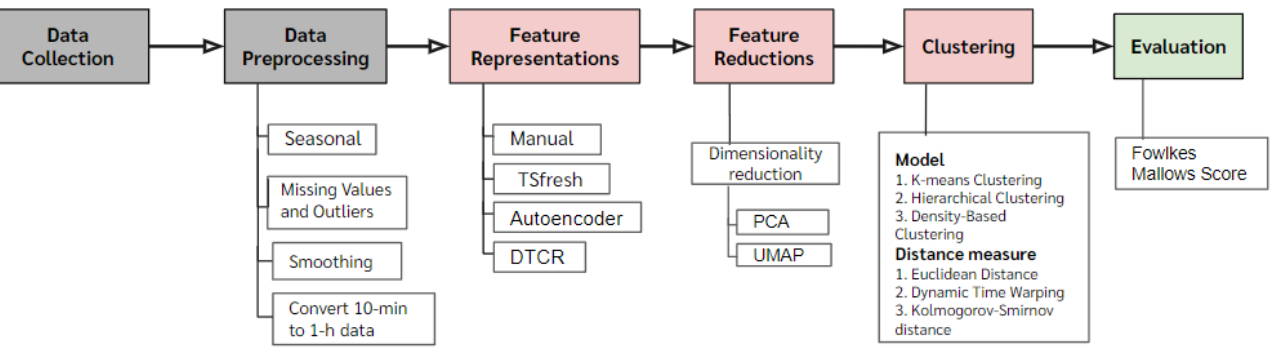
Figure 1. A flow process